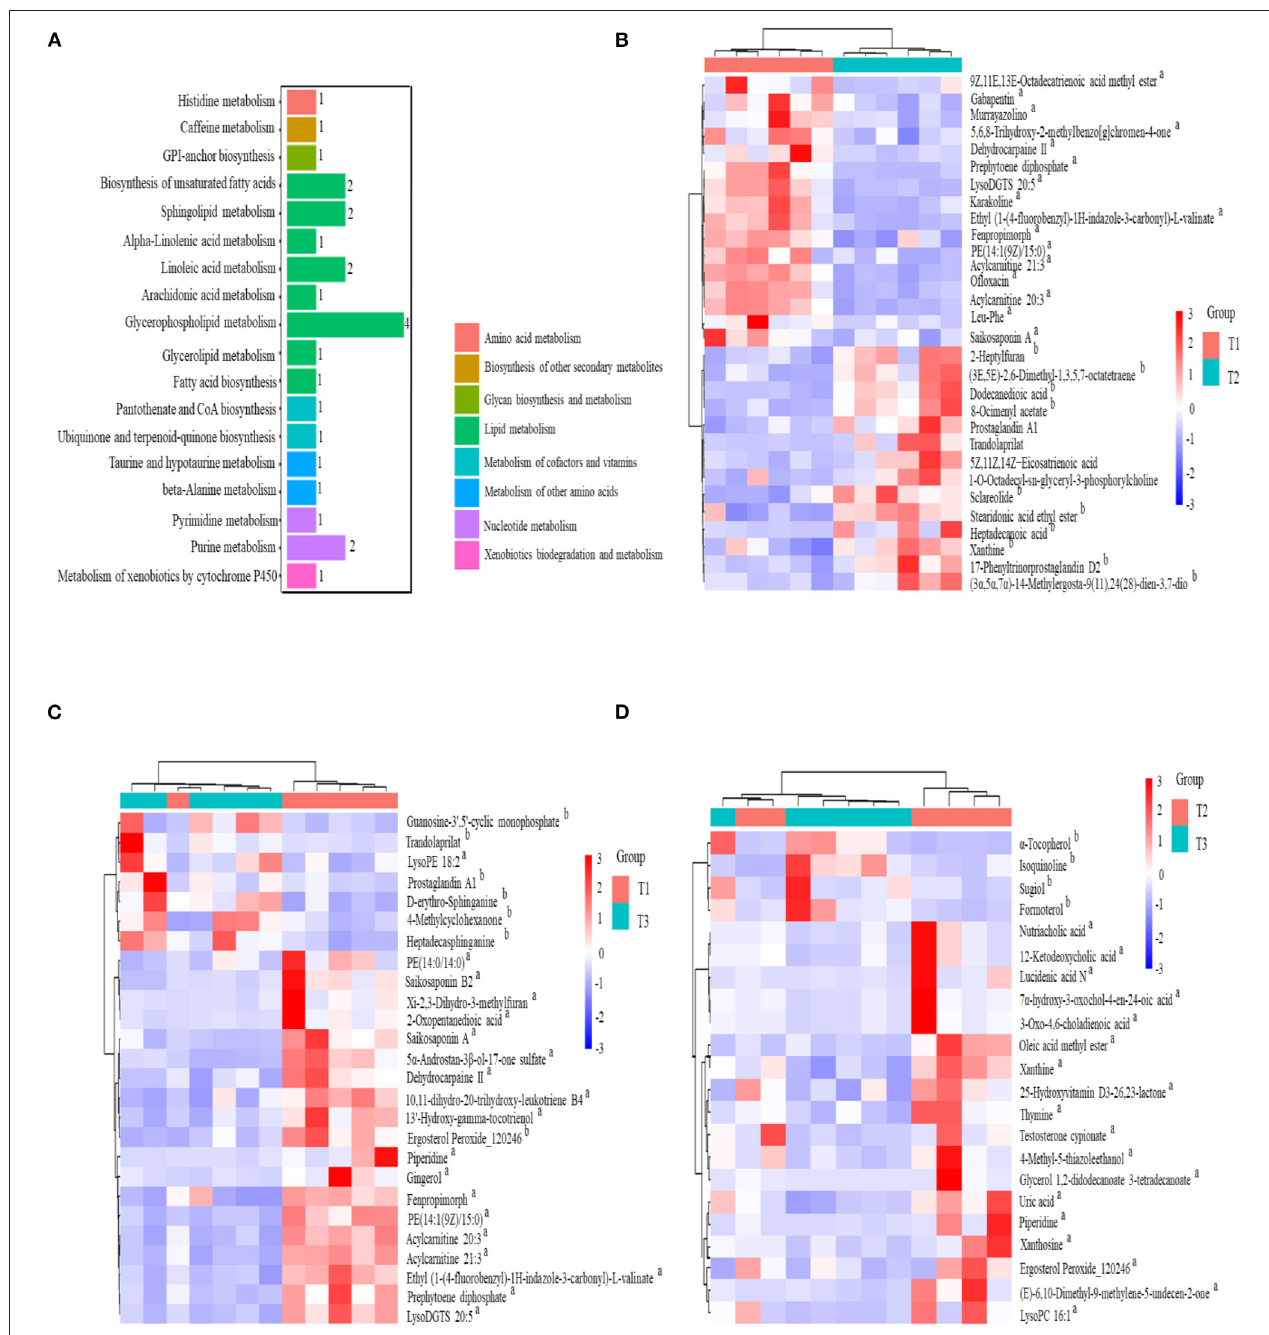
FIGURE 9 | KEGG classification of differentially accumulated MS2 metabolite (A) . Heat-map of hierarchical clustering analysis for the dietary groups in cecal tissue of goats using the identified metabolites in positive and negative ionization mode (B) T1 vs. T2; (C) T1 vs. T3; (D) T2 vs. T3. The upregulated and downregulated metabolite denoted by superscript “a” and “b”,